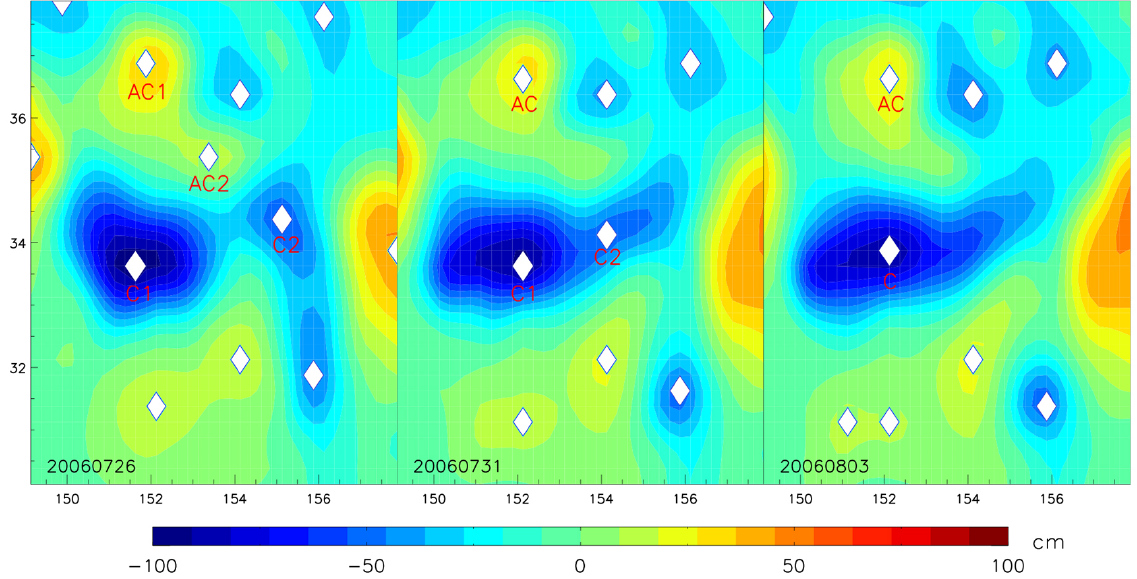
Figure 1. The evolutions of amplitudes and areas of eddies from 5 July to 3 August 2006 (after Li et al., 2014), where the background field shows the SLA, and white dots mark eddy centers. Two anticyclonic eddies AC1 and AC2 merged into a single eddy on 31 July 2006, and two cyclonic eddies C1 and C2 merged into a single one on 3 August